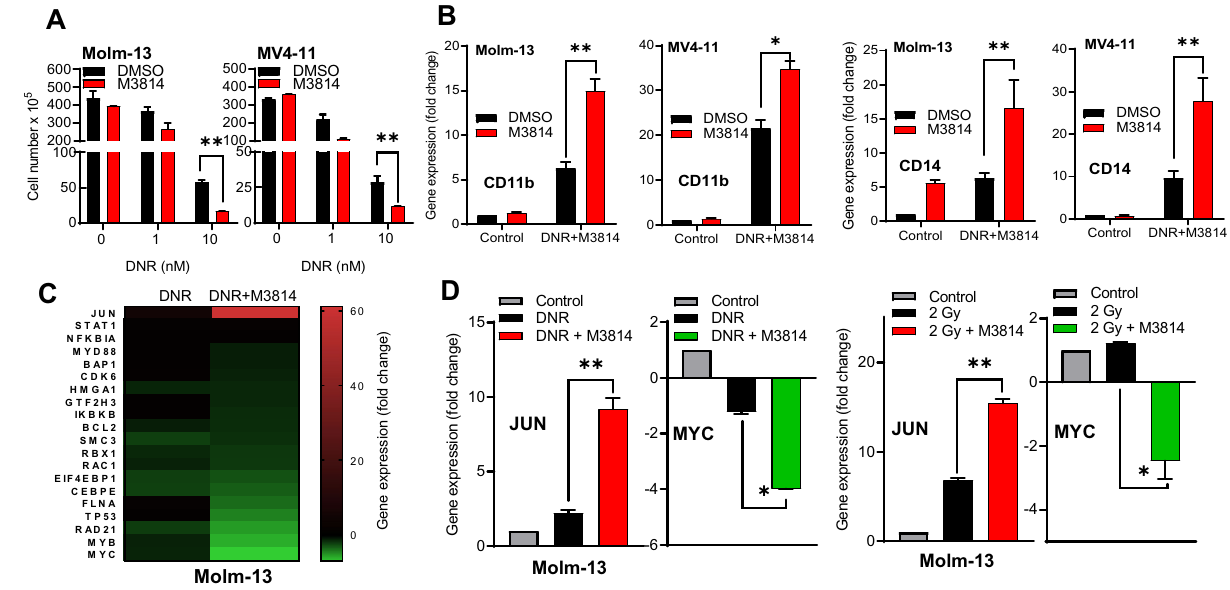
Figure 5. DNR/M3814 combination promotes the myeloid differentiation of AML cells. ( A ) Molm-13 and MV4-11 cells were left untreated or pre-treated with M3814 (300 nM) for 45 min before exposure to DMSO or daunorubicin (1 or 10 nM) and allowed to differentiate for 72 h. Equal number of viable cells were then re-plated in fresh media without inhibitors. Cell number was assessed by Trypan blue exclusion 72-h post- re-plating. ( B ) Molm-13 and MV4-11 cells were pre-treated as in A, then treated with daunorubicin (10 nM) or vehicle. RNA was isolated 24-h post-treatment. and the expression of the myeloid markers CD11b and CD14 was quantified by RT-qPCR. mRNA expression was normalized to GAPDH. ( C ) Molm-13, cells were pre-treated as in A, then treated with daunorubicin (10 nM) or vehicle. Gene expression was assessed using the nCounter Pan-Cancer Pathway Panel after 24 h. The changes in expression of a subset of genes previously associated with myeloid differentiation was displayed on a heatmap as a fold change over vehicle-treated Molm- 13 cells. ( D ) Molm-13 cells were pre-treated as in A. Cells were then treated with DMSO, daunorubicin (10 nM) or IR (2 Gy). RNA was isolated 24-h post-treatment and RT-qPCR was used to quantify the expression of JUN and MYC. mRNA expression was normalized to GAPDH. *p < 0.05, **p < 0.01, ***p < 0.001. NS: p >